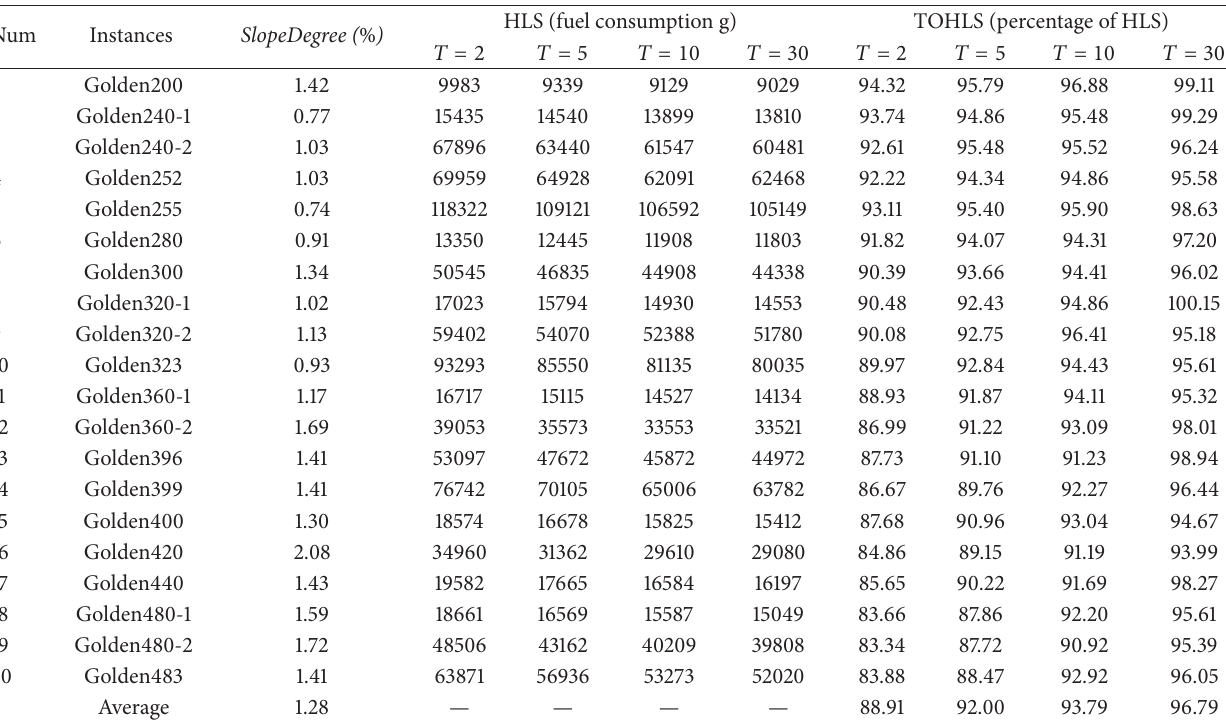
Table 7: Comparison between HLS and TOHLS when 𝑅 = 3000